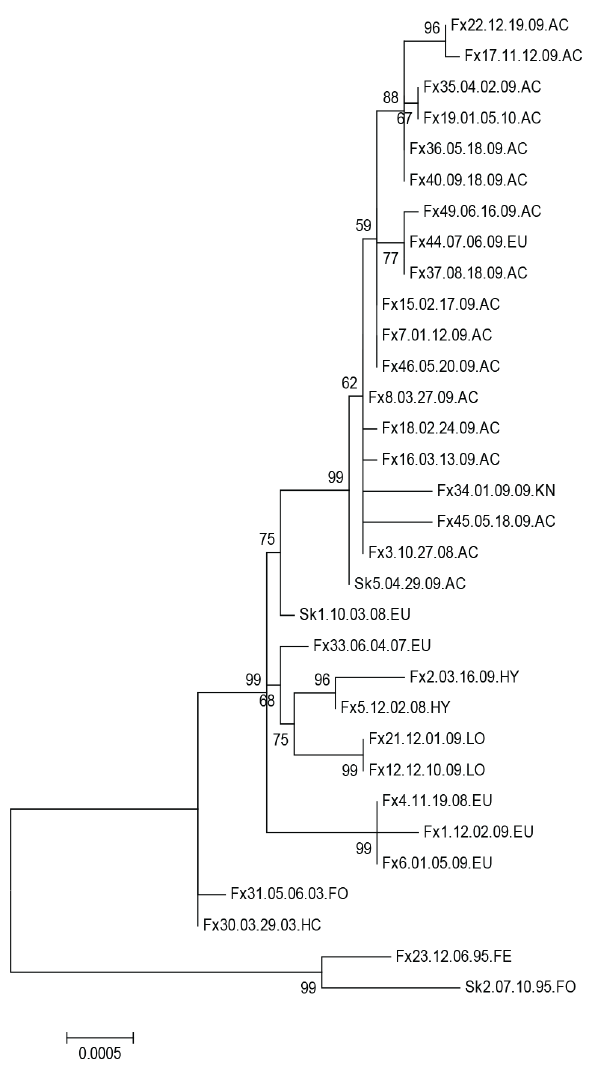
Figure 1. Phylogram generated from genomic sequences of Humboldt Co. skunk variant rabies samples collected between 1995–2010. The evolutionary history was inferred by using the Maximum Likelihood method based on the Tamura-Nei model. The tree with the highest log likelihood (-14363.5660) is shown. The percentage of trees in which the associated taxa clustered together is shown next to the branches. Initial tree(s) for the heuristic search were obtained automatically as follows. When the number of common sites was , 100 or less than one fourth of the total number of sites, the maximum parsi- mony method was used; otherwise BIONJ method with MCL distance matrix was used. The tree is drawn to scale, with branch lengths measured in the number of substitutions per site. The analysis involved 32 nucleotide sequences. All positions containing gaps and missing data were eliminated. There were a total of 9669 positions in the